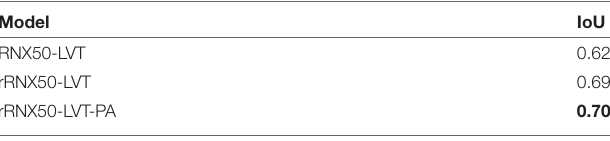
TABLE 4 | Analyzing different architectures of Chest L-Transformer (segmentation). Model